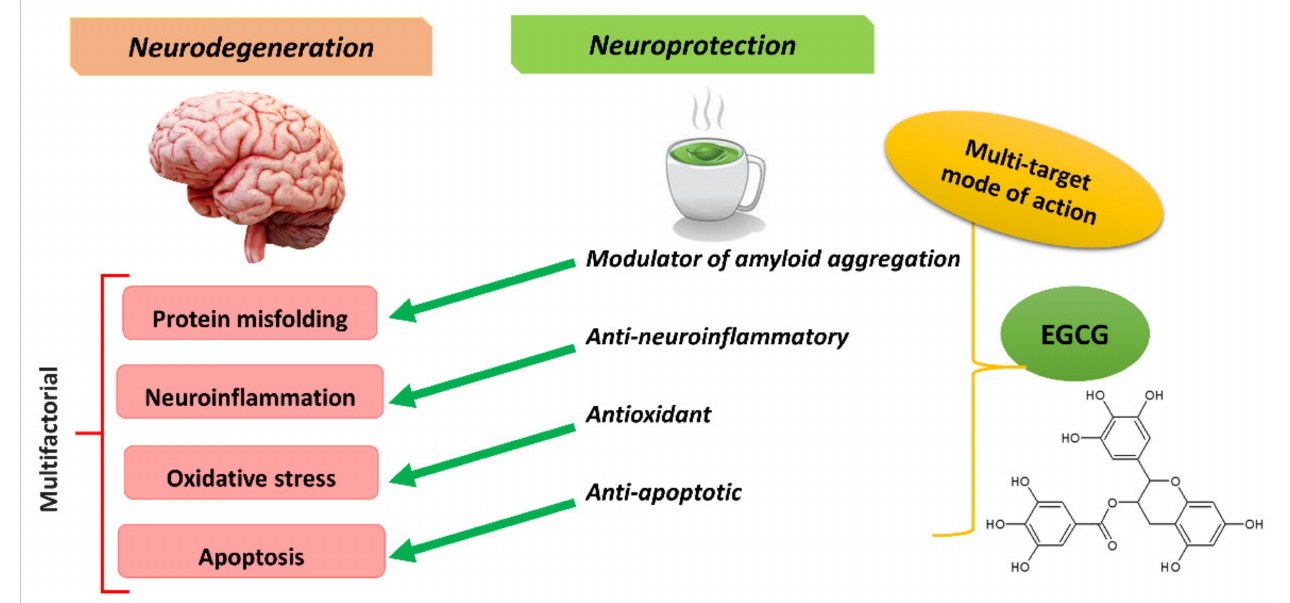
Figure 1. Schematic showing the role of epigallocatechin-3-gallate (EGCG) in neuroprotection. Neurodegeneration is a multi- factorial process, and preclinical models have shown that EGCG exerts neuroprotective effects through several